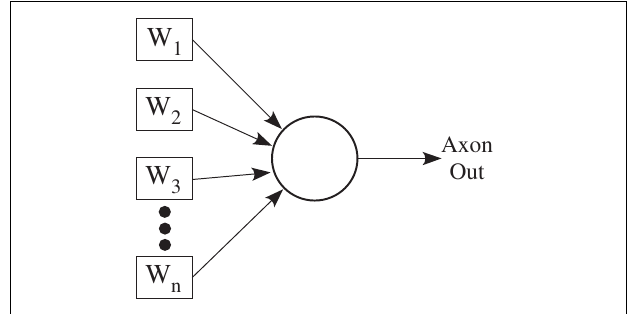
FIGURE 10 | Block diagram of a single neuron abstraction, typical in analog neural network (ANN)